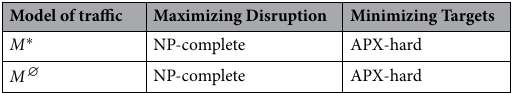
Table 1. Summary of our computational complexity